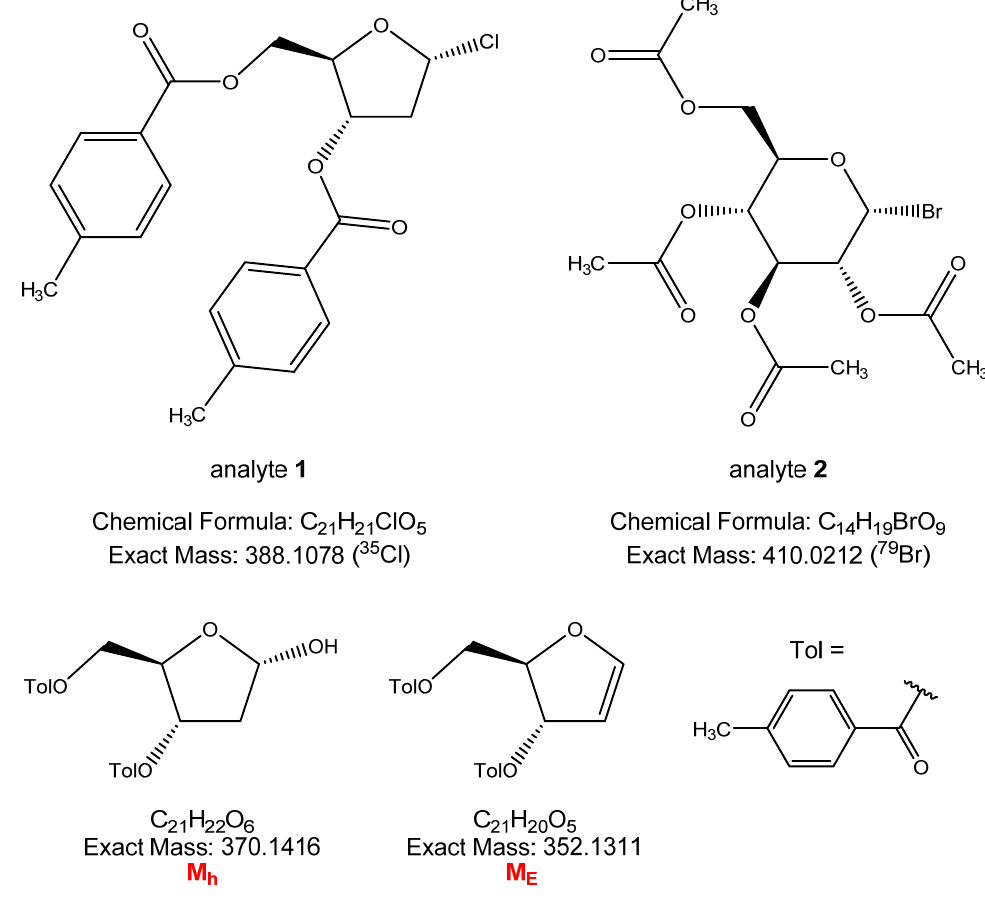
Figure 1. The structures of the analyte glycosyl halides 1 and 2 and the decomposition products of glycosyl chloride 1